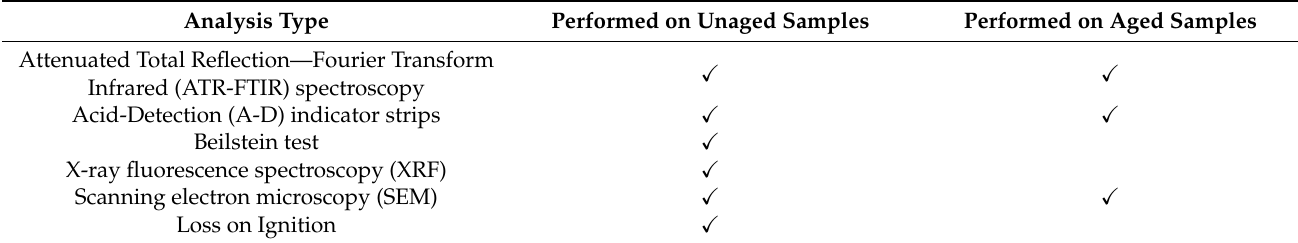
Table 2. Chemical analyses of